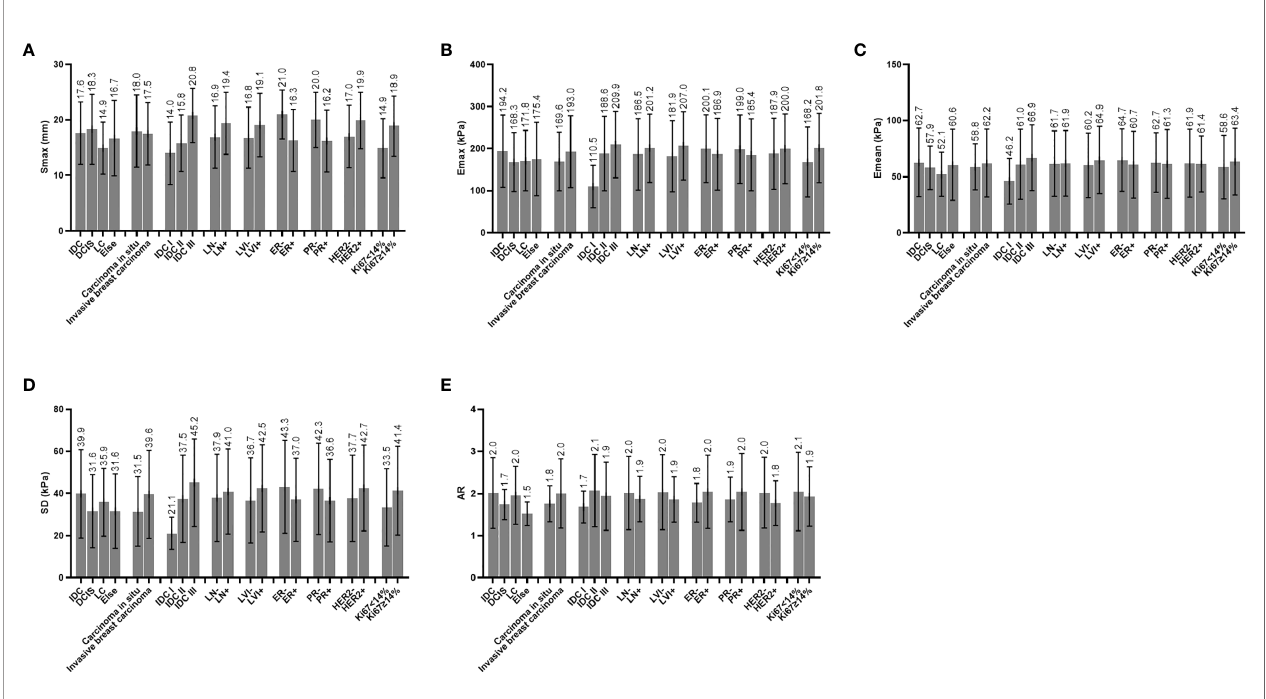
FIGURE 4 | (A) Distribution characteristics of S max between different groups. (B) Distribution characteristics of E max between different groups. (C) Distribution characteristics of E mean between different groups. (D) Distribution characteristics of SD between different groups. (E) Distribution characteristics of AR between different groups; IDC, invasive ductal carcinoma; DCIS, ductal carcinoma in situ; LC, lobular carcinoma; ALN, axillary lymph node status; LVI, lymphovascular invasion; ER, estrogen receptor; PR, progesterone receptor; HER2, human epidermal growth factor receptor 2; Ki67, Ki67 index; S max , maximal size; E max , maximal elasticity; E mean , mean elasticity; SD, standard deviation of elasticity; AR, area ratio of shear wave elastography to B-mode ultrasound.